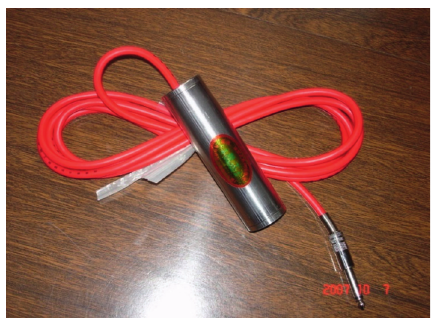
Figure 23: XJS-6 pore water pressure sensor.